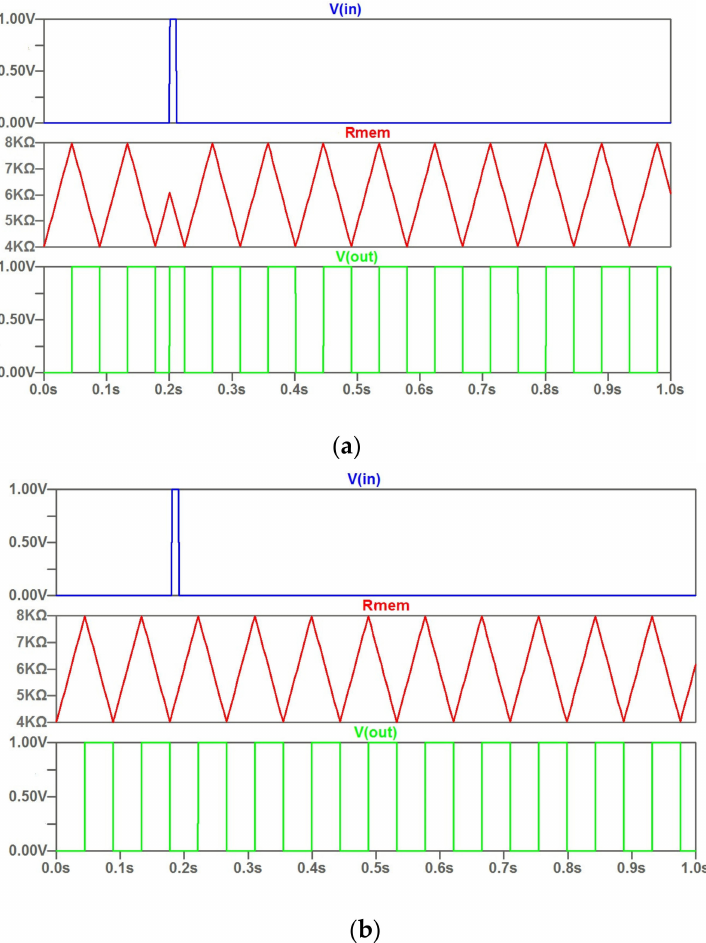
Figure 5. The potential control with a narrow input signal with impact ( a ) and without impact ( b ) on output pulse